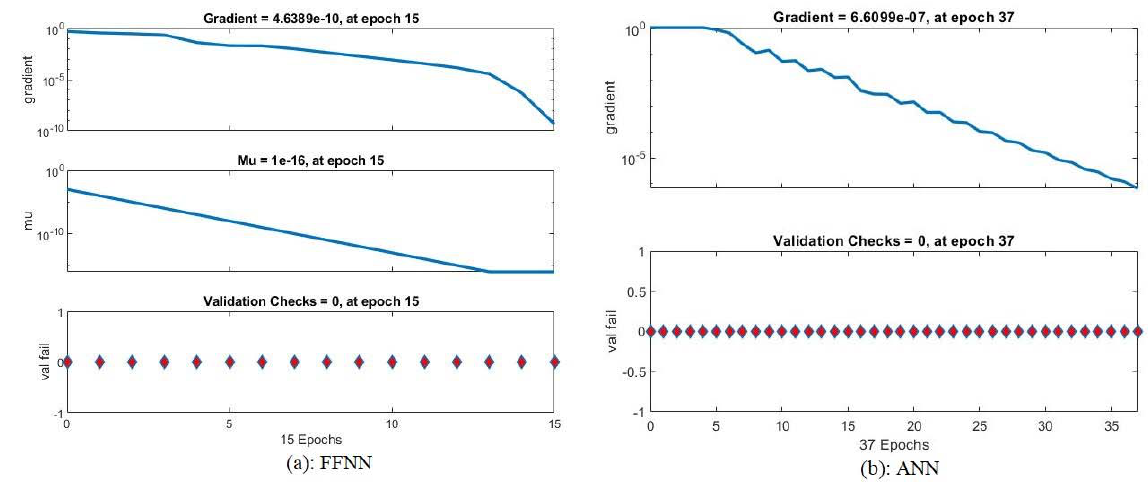
Figure 12. Display gradient and validation of ASD dataset. ( a ) FFNN algorithm and ( b ) ANN algorithm.